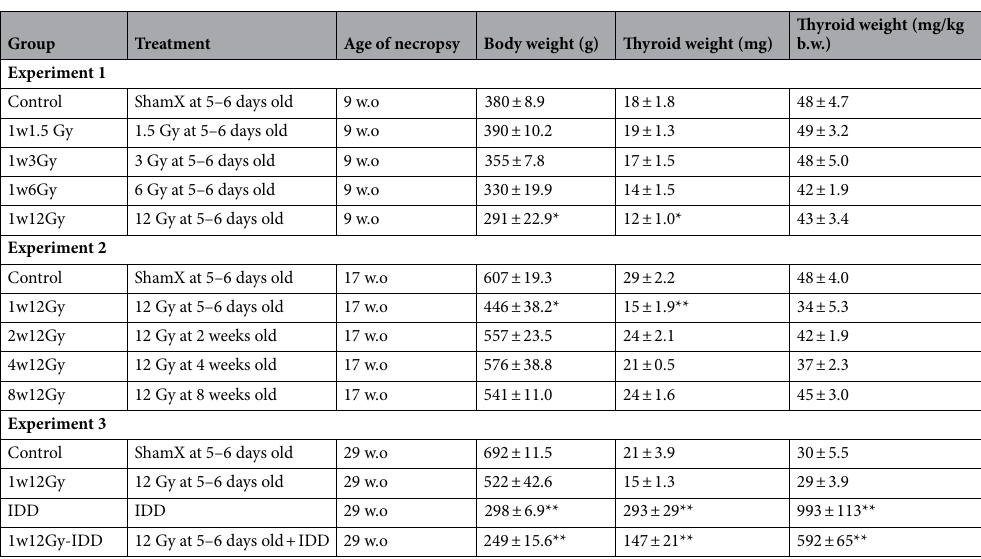
Table 1. Body and thyroid weights. The numbers of rats in each group were 6 rats/group in Experiment 1; 5 rats/group in Experiment 2; 4, 3, 7, and 8 rats in Control, 1w12Gy, IDD, and 1w12Gy-IDD, respectively, in Experiment 3. *, and ** indicate significant differences from each control (* p < 0.05; ** p <